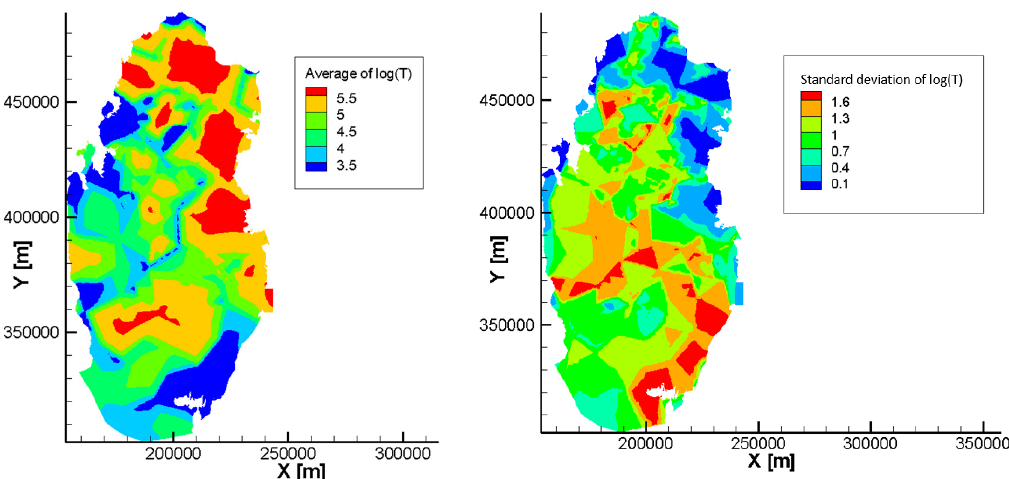
Figure 6. Average transmissivities (m 2 /day) expressed in log 10 (figure on the left). Standard deviation of transmissivities (m 2 /day) expressed in log 10 (figure on the right).